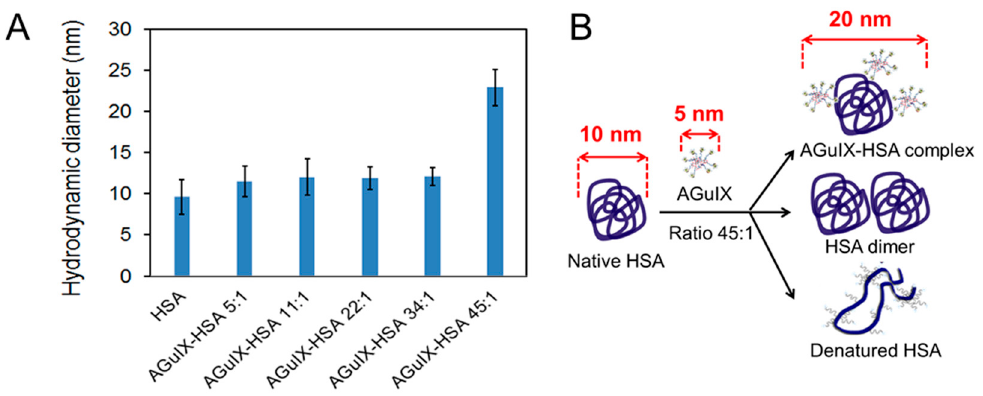
Figure 1. ( A ) Hydrodynamic diameters of pure HSA (human serum albumin) in the presence of AGuIX ® for di ff erent AGuIX ® :HSA ratios (from 5:1 to 45:1 NPs:HSA) in 10 mM phosphate bu ff er at pH 7.4, T ◦ = 37 ◦ C. ( B ) Schematic description of the possible interactions leading to doubling the HSA diameter in the presence of AGuIX ® at the highest concentration (ratio of 45:1).